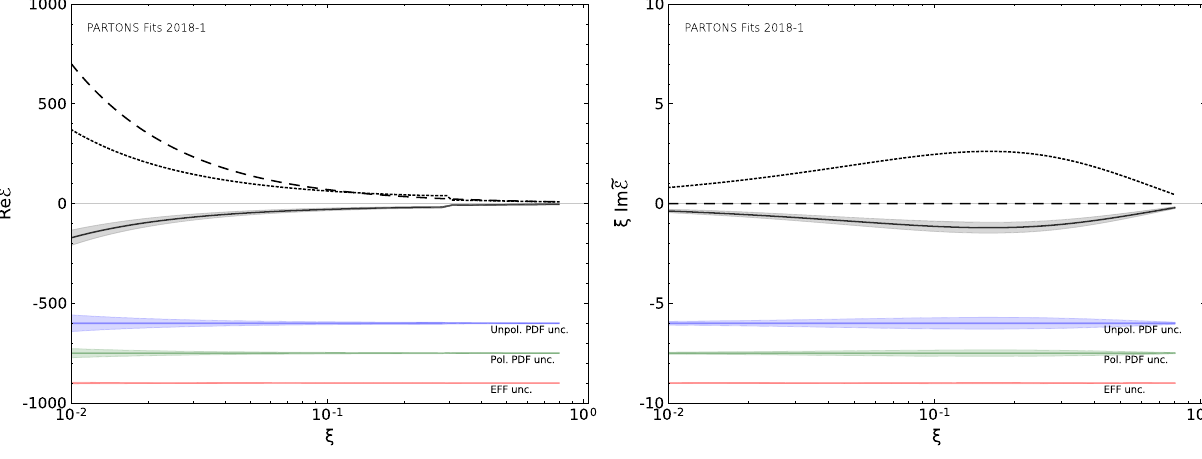
Fig. 14 Real (left) and imaginary (right) parts of the CFF (cid:8) E obtained in this work as a function of ξ at t = − 0 . 3 GeV 2 and Q 2 = 2 GeV 2 . For further description see Fig.